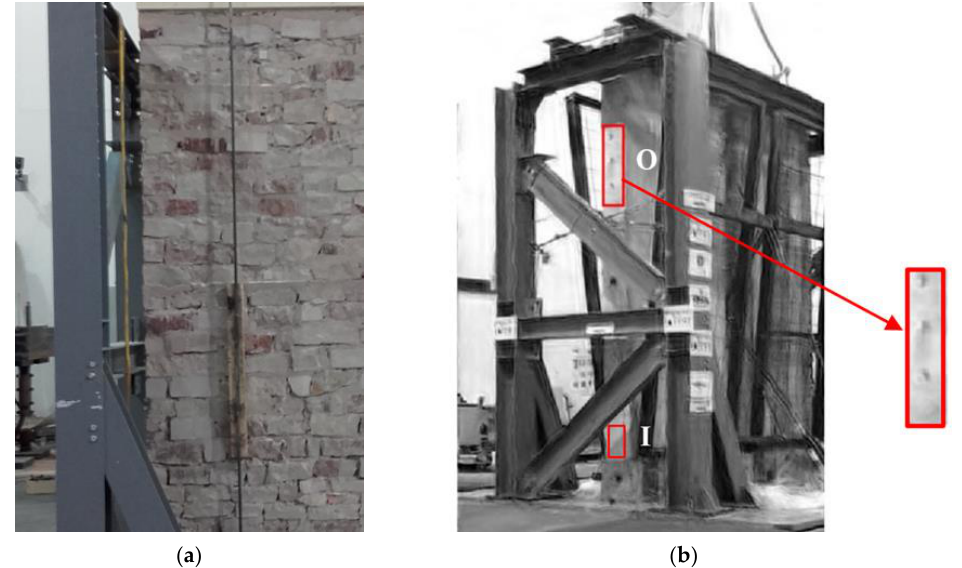
Figure 2. A historic masonry wall typical of central Italy tested on shaking table: ( a ) Detail of the wall during setup preparation. ( b ) The red boxes indicate the O and I ROIs used as output and input signals in the FRF, respectively. The O ROI is enlarged on the right to enhance the three markers used as reference.